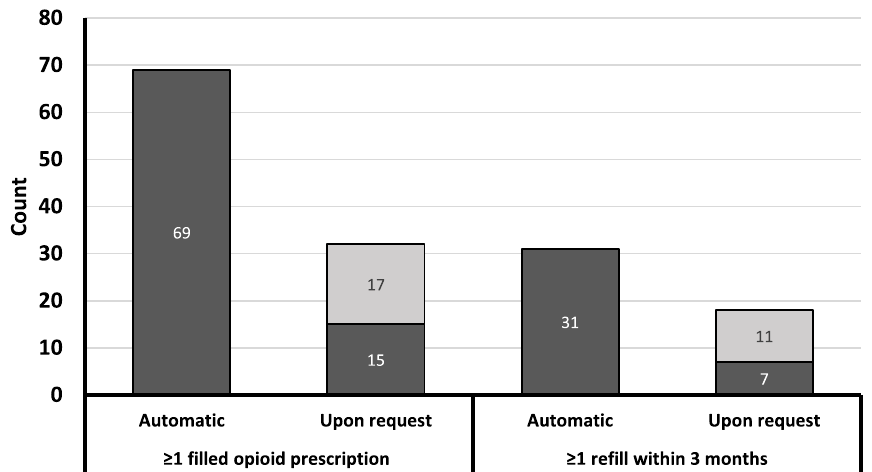
Fig. 1 Number of Patients with at Least One Initial and Refill Opioid Prescription During the First 3 Months After TKA. Dark gray indicates patients whose opioids were prescribed by a member of the orthopedic team and light gray indicates patients whose opioids were prescribed another provider